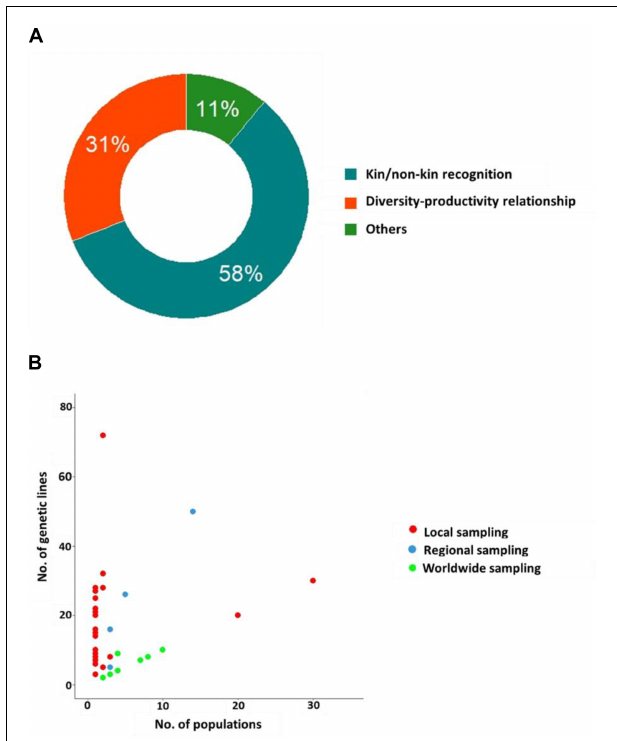
FIGURE 2 | Classification of experimental studies on GxG interactions. (A) Doughnut plot describing the distribution of the papers according to the rationale of studying GxG interactions. (B) Relationship between the number of genetic lines and the number of populations according to three geographic scales. For better illustration, the two outliers with 60 genotypes each from a different population, are not incorporated in the figure (Fitzpatrick et al., 2019; Turner et al.,